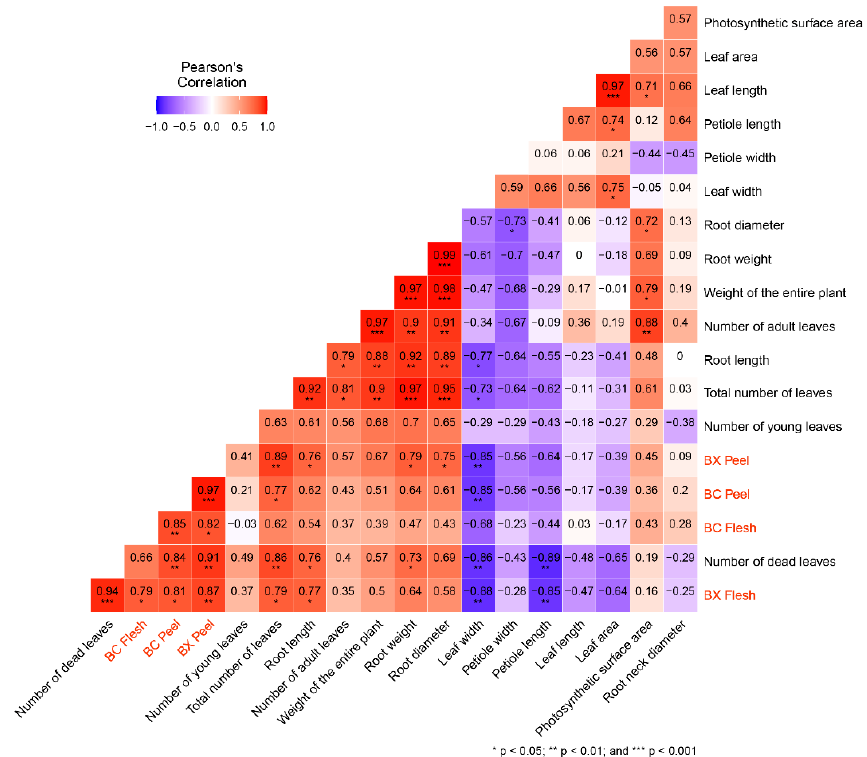
Figure 4. Correlogram showing the correlations between different morphological characters and table beet betalains in the red-colored groups 1 and 2 ( n = 100 replications). The numbers inside each square show the Pearson R correlation values.